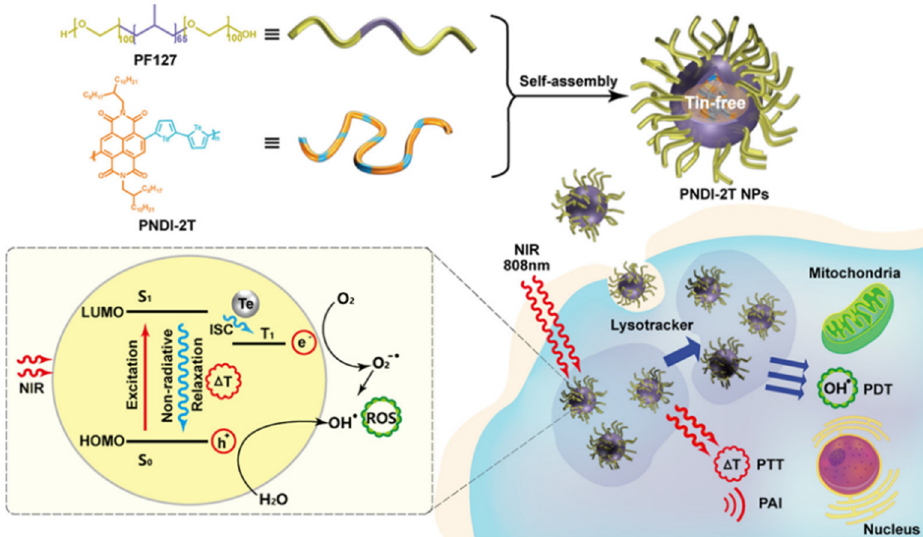
Figure 7 . Schematic illustrations of the preparation of NPs for a PAI-Guided PDT/PTT and proposed photo-physical mechanism (Reprinted Permission American Chemical Society, 2019) [104] .